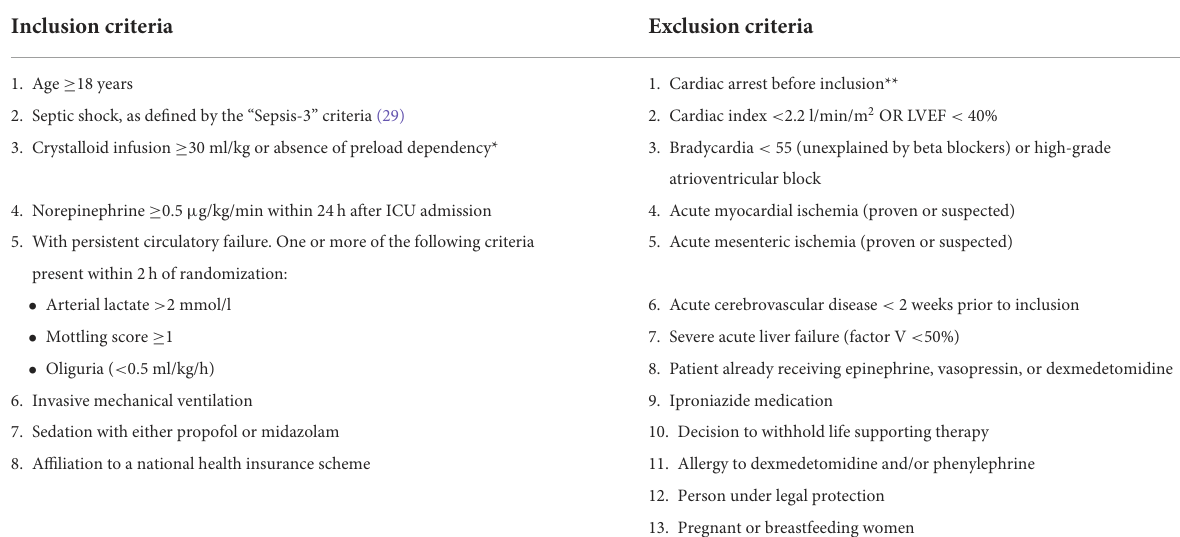
TABLE 1 Inclusion and exclusion